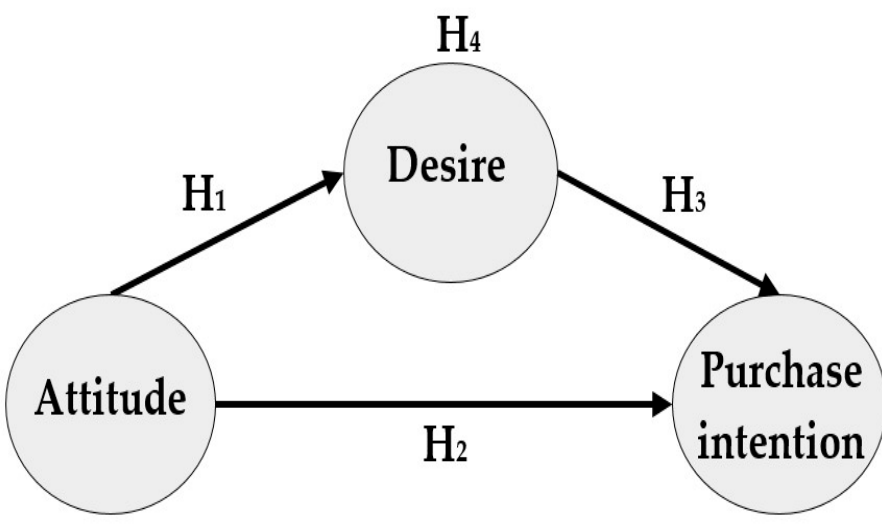
Figure 1. Hypothetical investigation model.